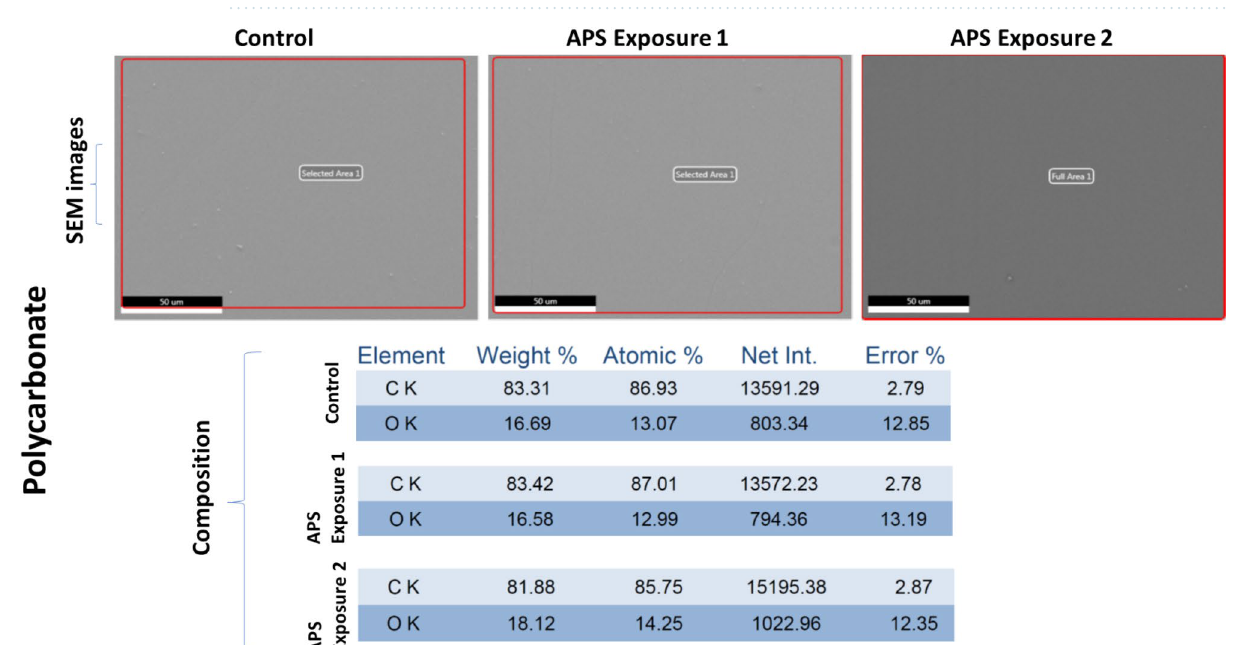
Figure 15. Material compatibility data: SEM analysis of Aluminum with APS exposure 1: exposed to ozone CT value of 6789.02 ppm-min, and APS exposure 2: exposed to ozone CT value of 10,323 ppm-min.